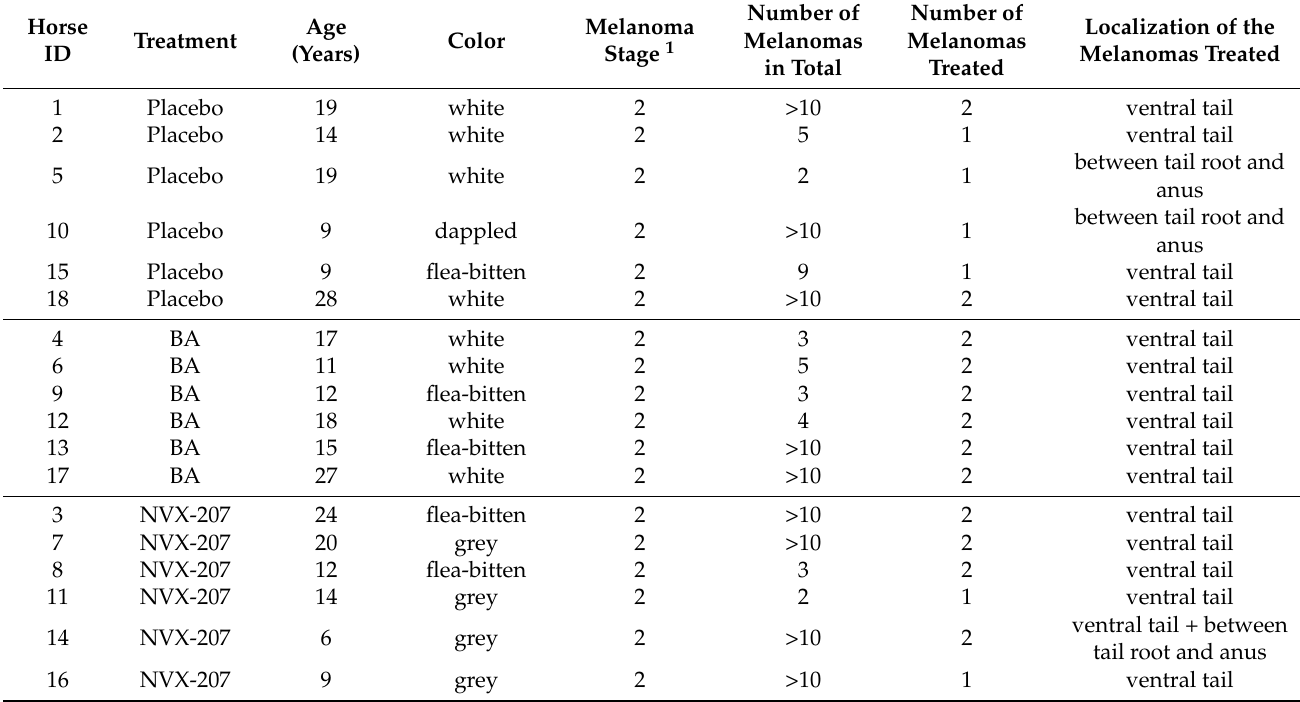
Table 1. Characteristics and group assignment of the 18 Lipizzaner